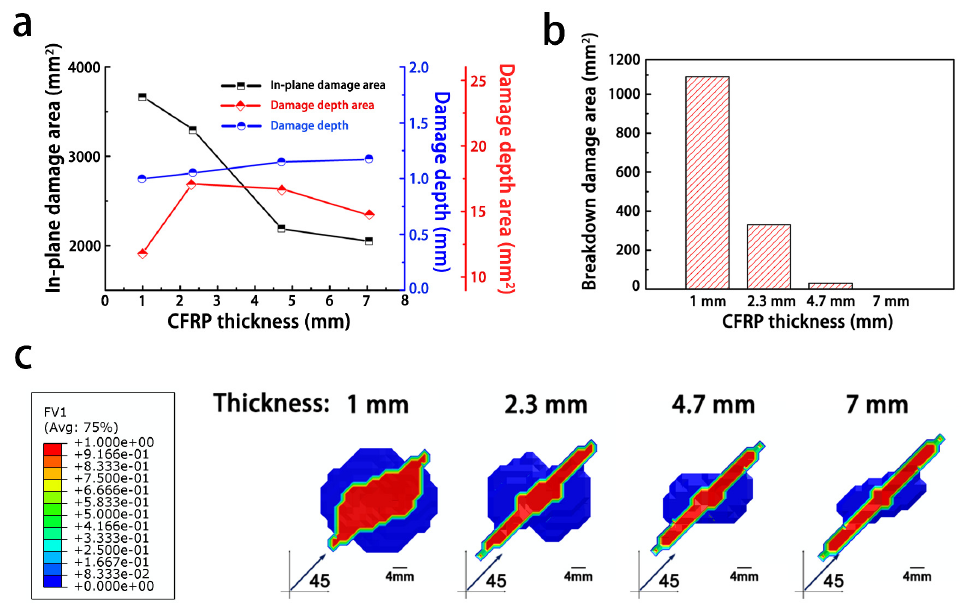
Figure 8. The influence of the composite thickness on the degree of lightning damage to the compo- sites: ( a ) degree of damage to the composites; ( b ) breakdown area of the composites; ( c ) damaged area